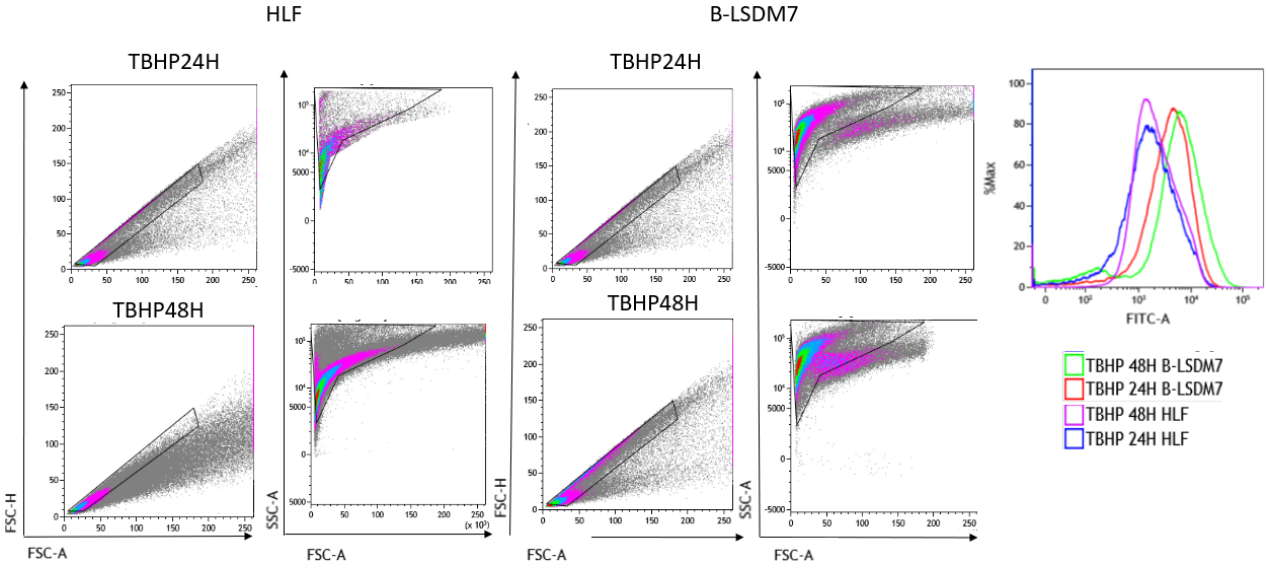
Figure 9. The detection of reactive oxygen species (ROS) through Flow cytometric analysis. The use of TBHP was applied as an oxidant. The status of oxidation of B-LSDM and HLF were performed through CellROX® Green Flow Cytometry Assay Kits.